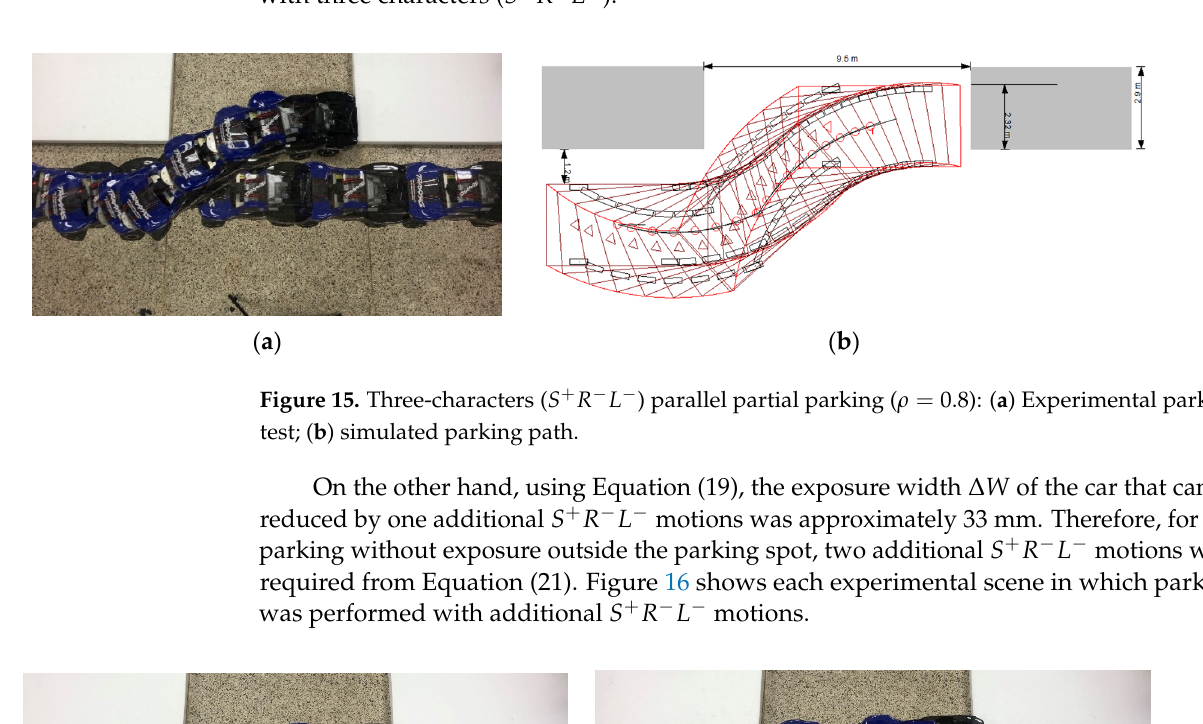
Figure 14. Success of three-characters ( 𝑆 (cid:2878) 𝑅 (cid:2879) 𝐿 (cid:2879) ) parallel full parking ( 𝜌 = 1 ): ( a ) Experimental park- ing test; ( b ) simulated parking path.